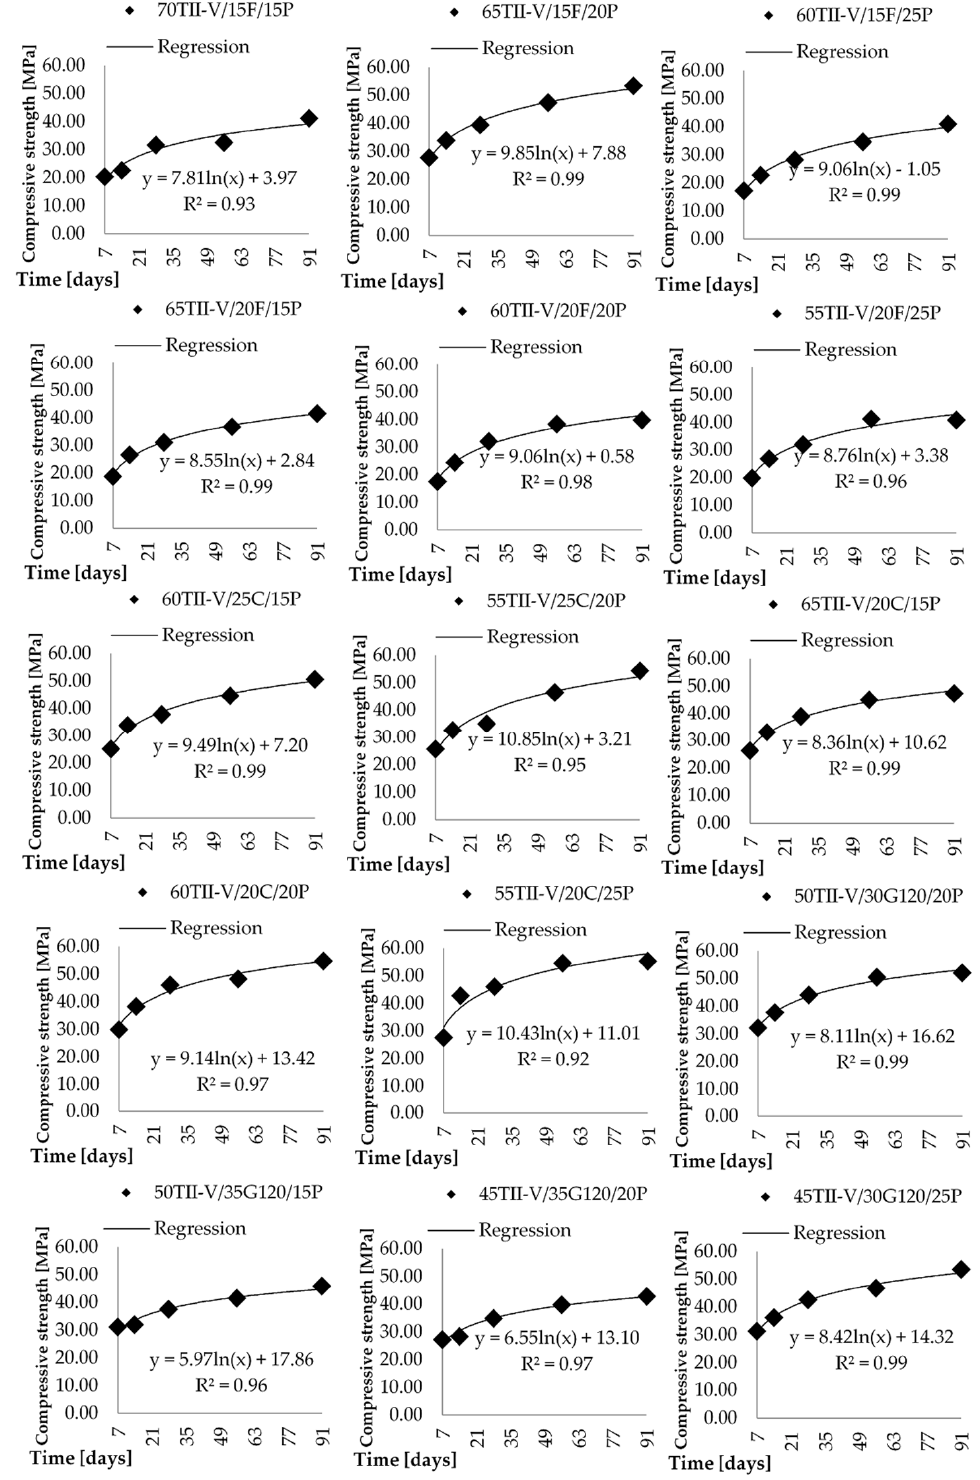
Figure 4. Correlation of strength versus concrete age for pumice, metakaolin, and silica fume-based mixtures.